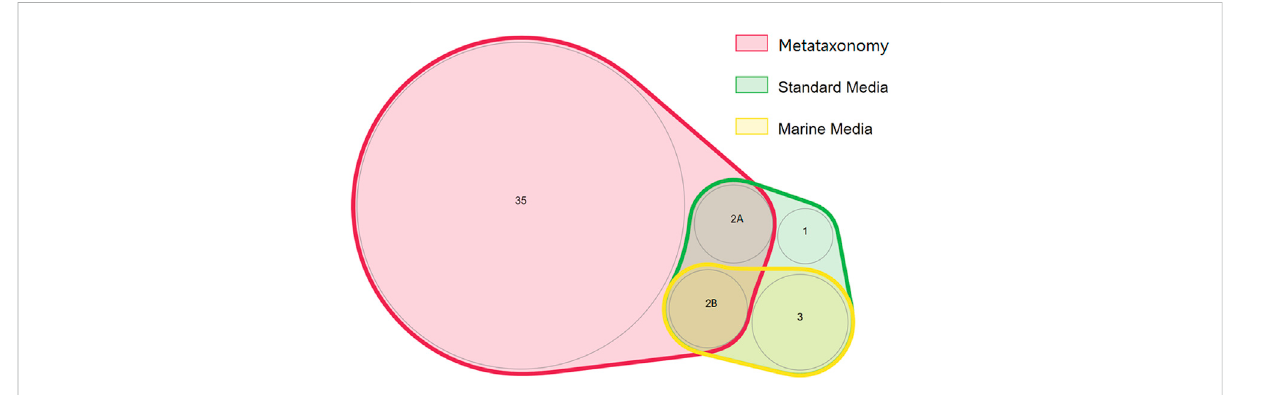
FIGURE 5 Proportionally scaled Venn diagram of microbial orders detected using culture-dependent and culture-independent approaches. “ Marine media ” correspondtoBG11,GMW,MA,SS,andSSGmedia. “ Standardmedia ” correspondstoTSA,PDA,M7H9,BA,THIO,andMHmedia.Thenumbers inside each circle correspond to the number of orders detected. The orders are the following: 1 — Sphingobacteriales; 2A-